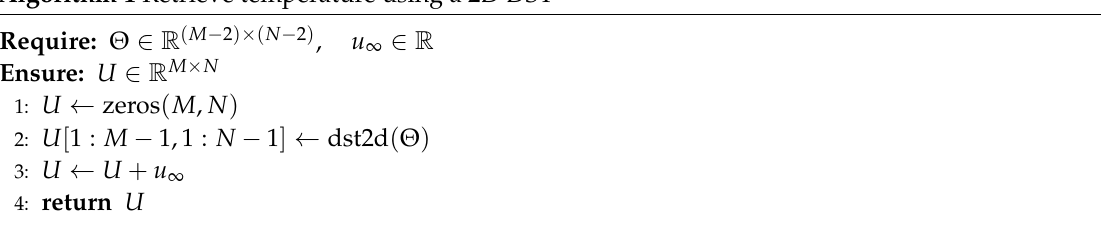
Algorithm 1 Retrieve temperature using a 2D DST